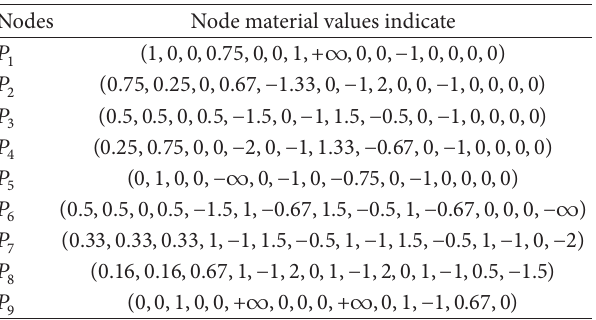
Table 1: The material distribution definition for